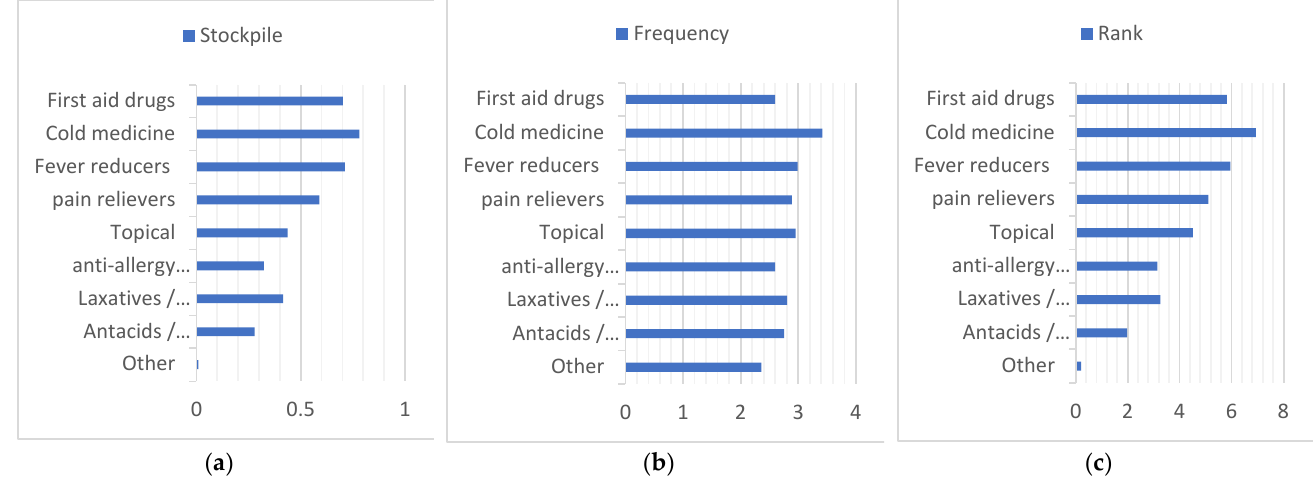
Figure 5. Summary of the overall drug stockpile, frequency of drug use, and ranking of drug importance. ( a ) Stockpile, ( b ) Frequency, ( c ) Rank.